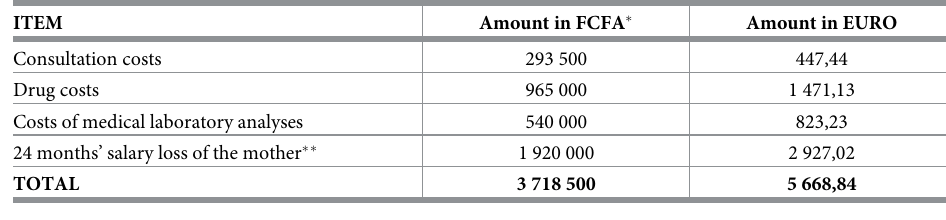
Table 1. Details of the expenses for case management of the patient between October 2014 and September